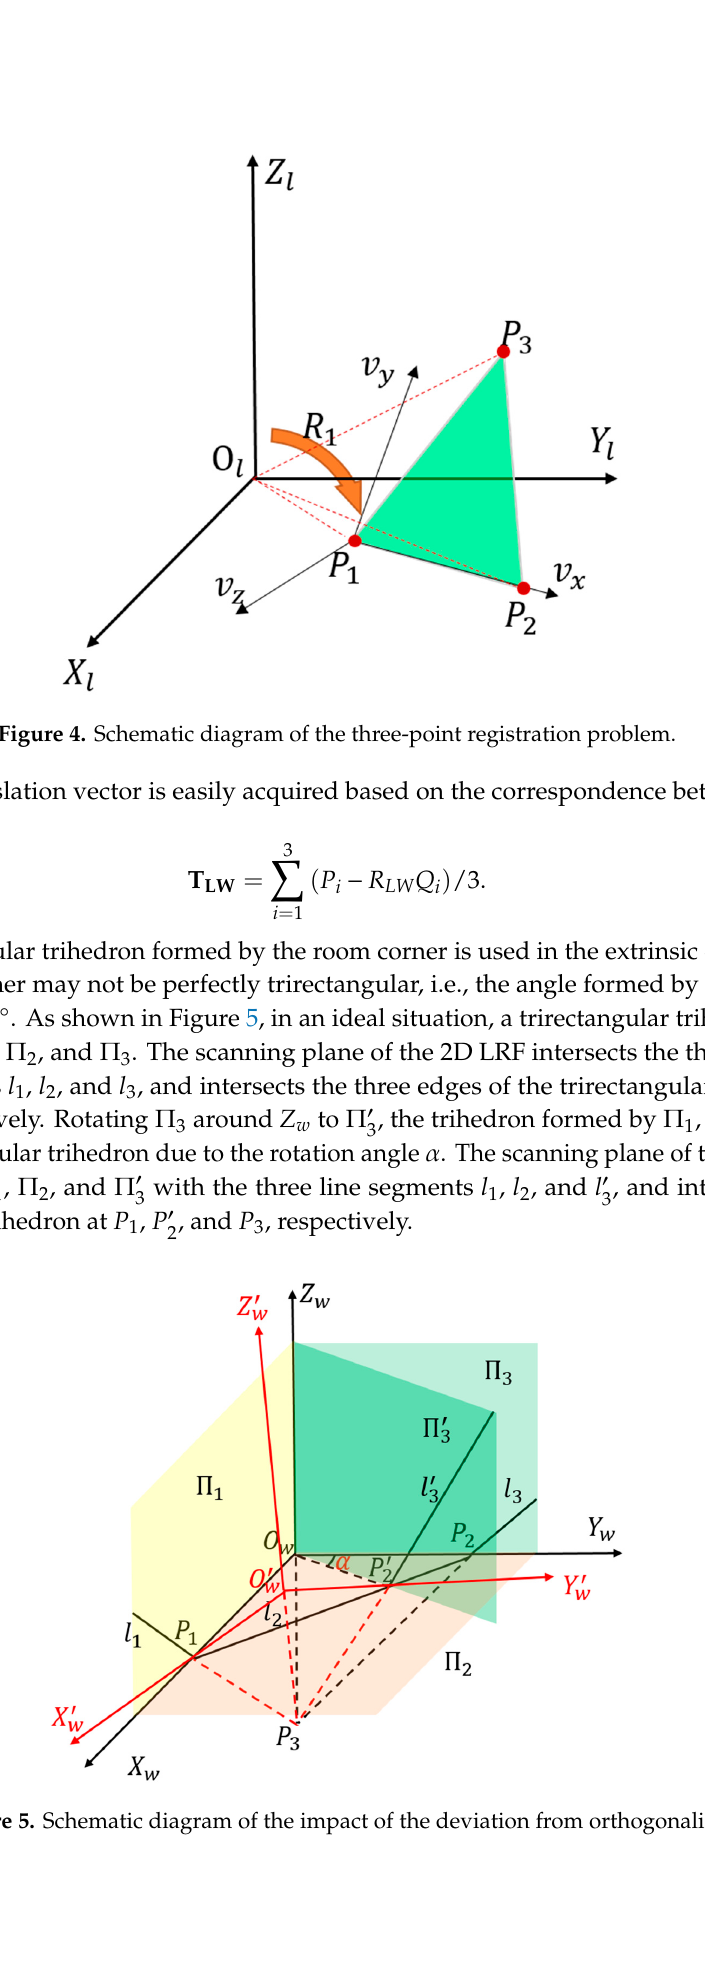
Figure 5. Schematic diagram of the impact of the deviation from orthogonality.